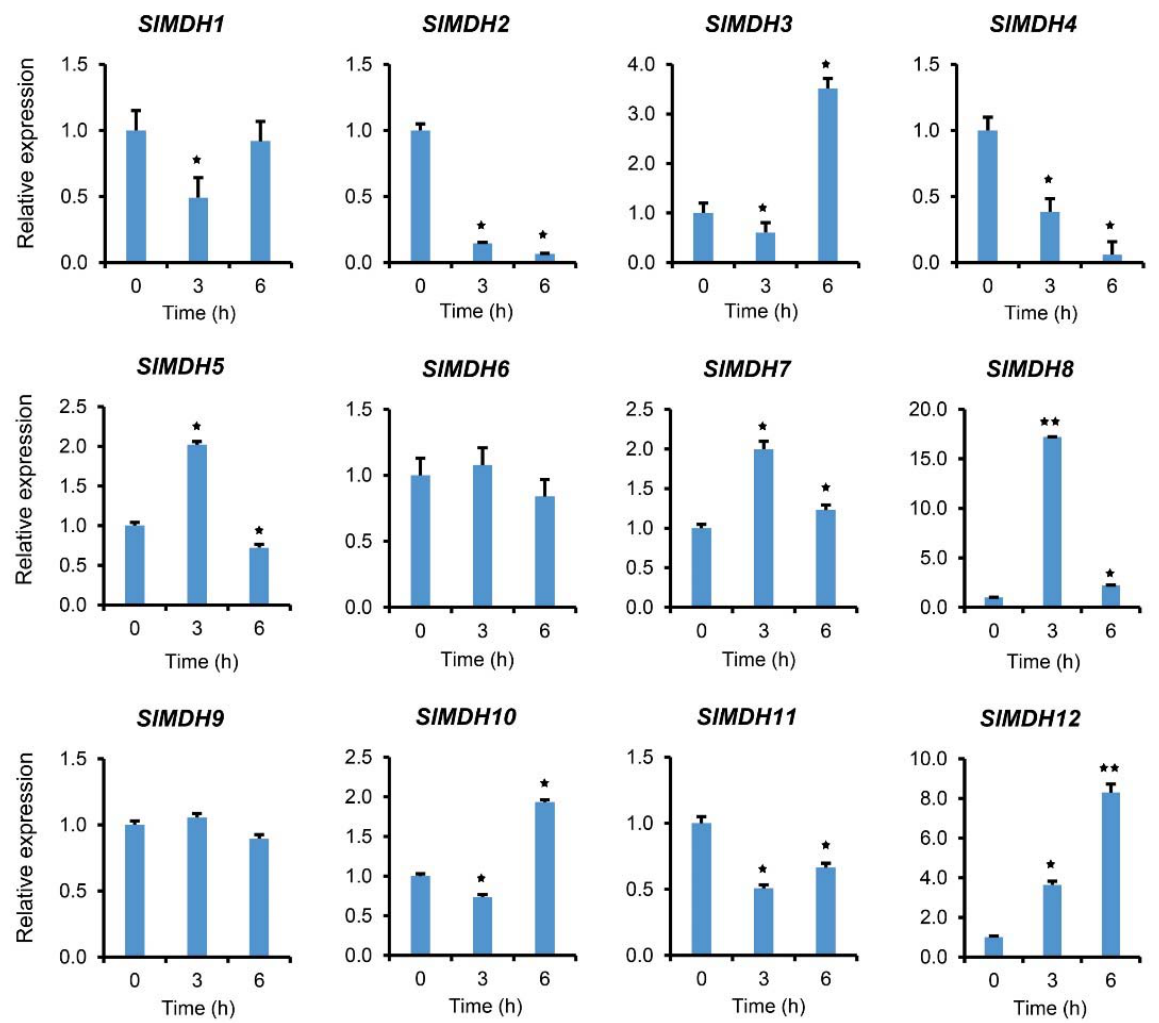
Figure 7. Gene expression analysis of tomato MDH genes in response to salt stress at different time points “0, 3, and 6 h” under 250 mM NaCl treatments. The relative expressions at different stress treatment times were compared with the control (0 h) and the control was set 1 to count fold change expression. Actin was used to normalize the data. Three biological replicates were used in the experiment. Error bars denote standard errors of the means of three independent technical replicates. The asterisks indicate significant differences, as determined by Student’s t ‐ test (* p ‐ value ≤ 0.05, ** and p ‐ value ≤ 0.01).